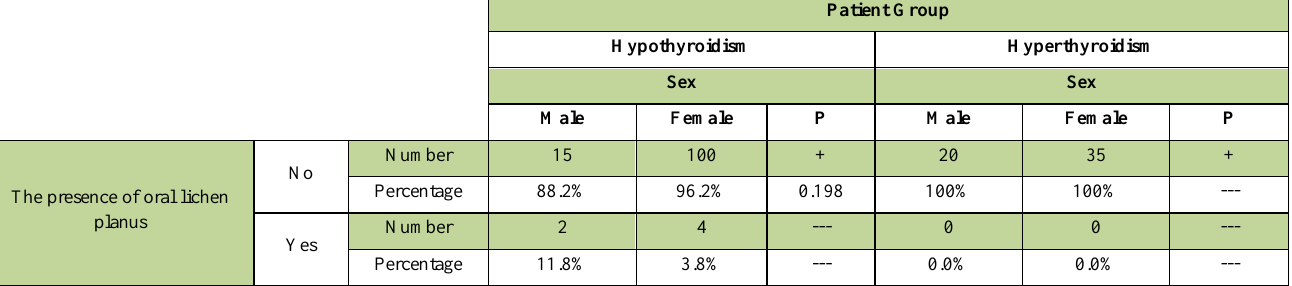
Table 5. Comparison of oral lesions in two groups of patients based on